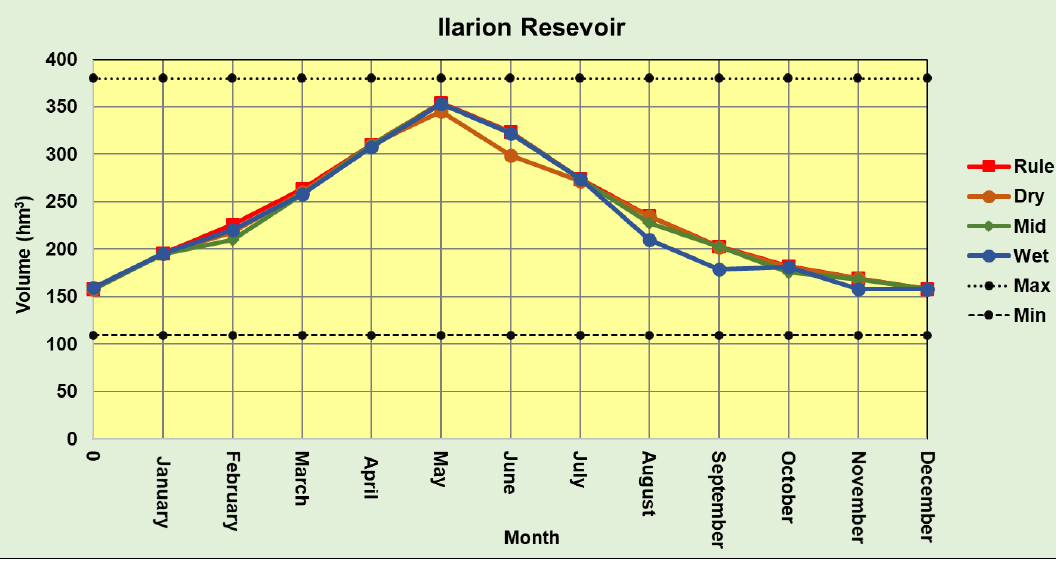
Figure 11. The optimal operation policies for the current state of water resources demand, applying the institutional operating rule curves for the Ilarion reservoir.